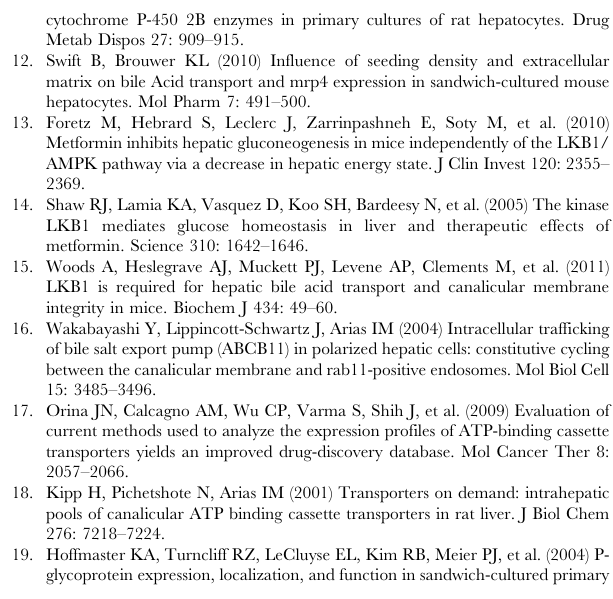
Figure S5 Expression profiling of transporters in the liver of control and LKB1 2 / 2 mice. The mRNA expression levels of 53 murine Abc transporters and two major bile acid uptake transporters (Ntcp/Slc10a1 and Oatp1/Slco1c1) were determined from liver samples of control and LKB1-deficient mice by quantitative PCR. Fold change in the expression levels of transporters in LKB1 2 / 2 versus control samples are shown for the major liver transporters ( A ) and the full array of transporters ( B ). In the later only two-fold or greater differences are indicated. Means 6 S.E.M. of two independent experiments measured in triplicates are shown. Figure S6 Representative Western blots for LKB1, AMPK and phosphorylated AMPK. Total cell lysates of cultured hepatocytes from control and LKB1 2 / 2 mice on day 6 were immunoblotted, and stained with antibodies specific to LKB1, AMPK, and phospho-Thr172 AMPK (phAMPK). The upper 3 panels show the same blot developed with different antibodies, while the lower 2 panels depict another blot for phAMPK. For loading control actin staining was used. Pretreat- ments: TC – 100 m M taurocholate, AICAR - 500 m M AICAR, cAMP - 200 m M for 24 hours. Video S1 Three dimensional structure of the canalicu- lar network in mouse hepatocytes. The tight junctional protein, ZO-1 was immumostained in a collagen sandwich culture of mouse hepatocytes on day 6. Stack of fluorescent confocal images are reconstituted and rotated. As demonstrated, normal mouse hepatocytes regain their polarity and form interconnecting canalicular structures in these cultures. Video S2 Expression of YFP-tagged ABCB11 in cultured mouse hepatocytes. A collagen sandwich culture of mouse hepatocytes was transduced with adenovirus containing YFP- tagged ABCB11 three days after cell isolation and seeding. Stack of fluorescent confocal images were acquired on day 6. The three dimensional image reconstituted from the stack demonstrates high expression in the canalicular membrane of the transduced